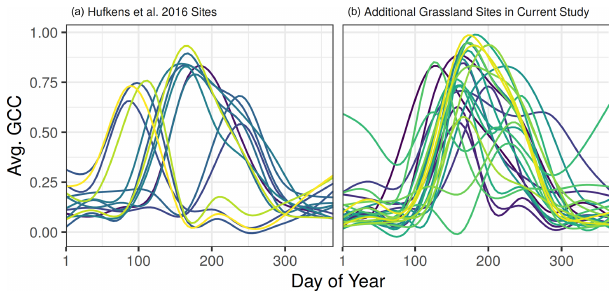
Figure 5. Smoothed time series for all 14 grassland sites used in Hufkens et al. (2016) (a) and 24 additional grassland sites added in the current study (b) . Each line represents the long-term average green chromatic coordinate of a single site across all available years, smoothed using a GAM